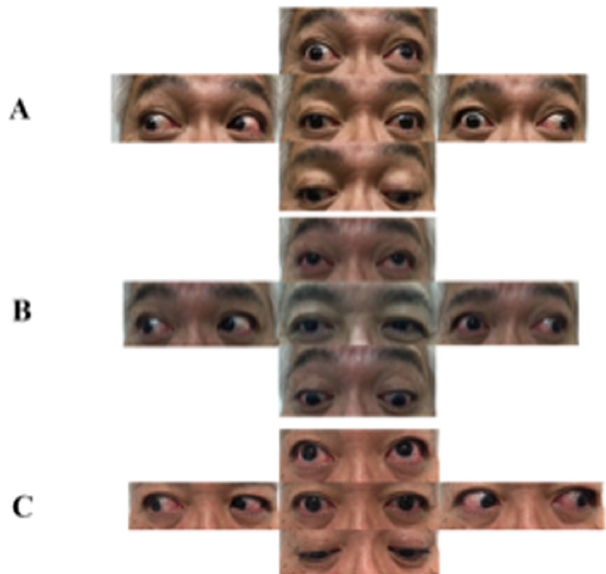
Figure 1. Eye movement of the patient demonstrating right oculomotor nerve palsy. ( A ) Mild blepharoptosis, limitation of adduction and vertical gaze on the right side on day 30. ( B ) The limitation of adduction and vertical gaze improved and ptosis completely resolved after IVIG treatment (day 52). ( C ) He completely recovered on day